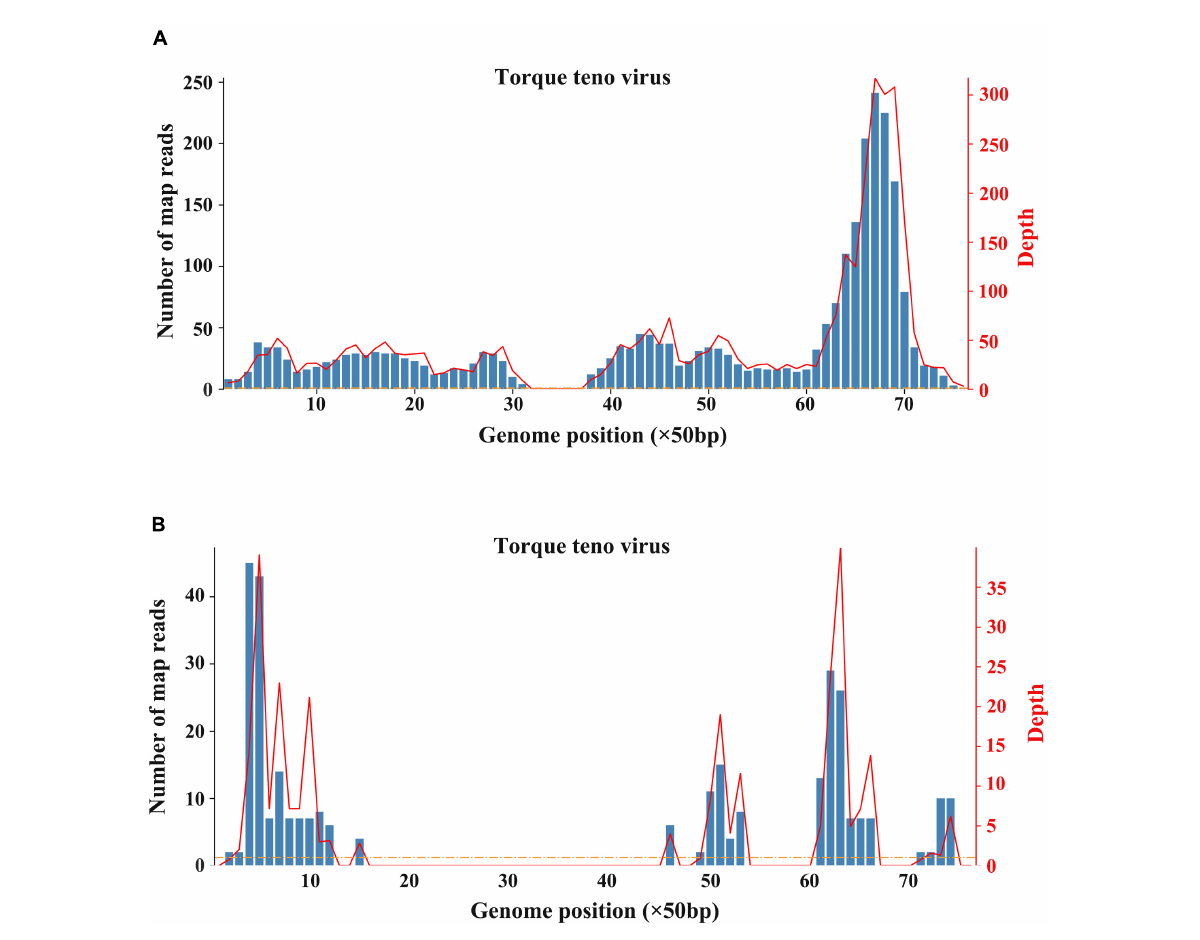
FIGURE3 Results of metagenomic sequencing. (A) Sequencing results of whole blood. (B) Sequencing results of liver